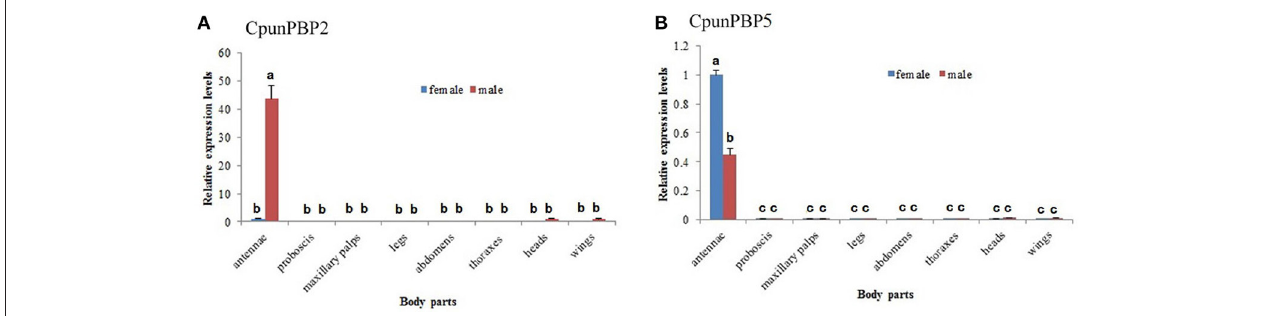
FIGURE 7 | Expression pattern analysis of CpunPBP2 and CpunPBP5 in different tissues. (A) Expression levels of CpunPBP2 in different tissues. (B) Expression levels of CpunPBP5 in different tissues. The different letters (a, b, c) above each bar represented significant differences ( p < 0.05).